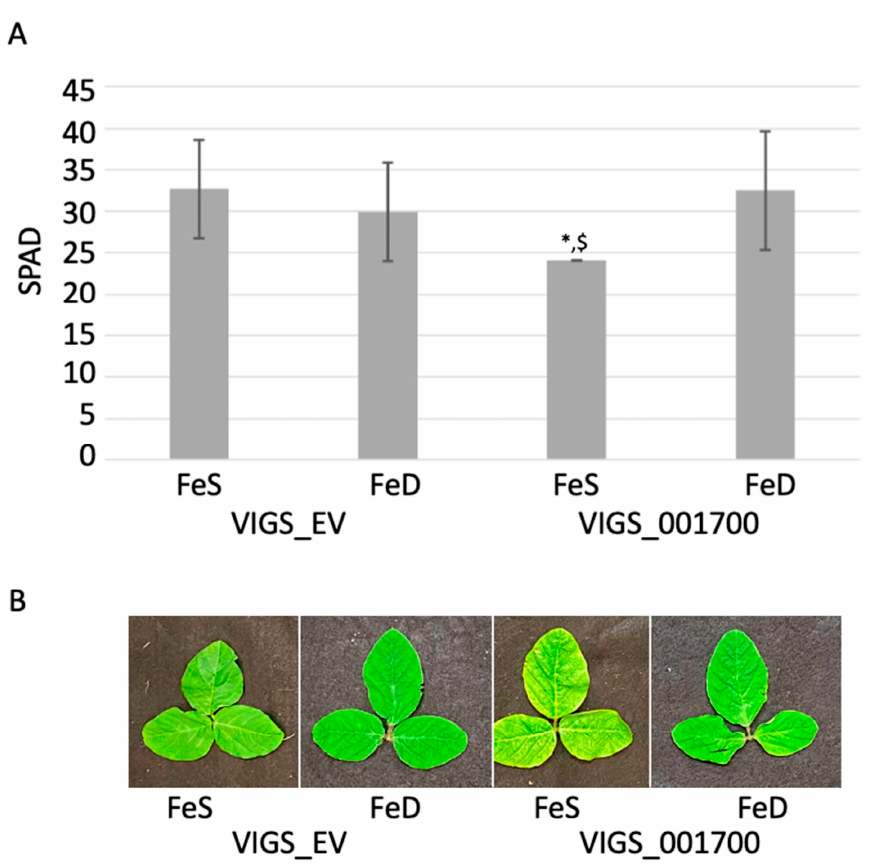
Figure 2. Phenotypic analysis of Fiskeby III infected with either empty vector or Glyma.05G001700 VIGS constructs in FeS and FeD hydroponic conditions. ( A ). SPAD readings at 14 days in hydroponics. Error bars are standard deviations calculated from six biological replicates. * indicates statistically significant differences between VIGS_Glyma.05G001700 in FeS and FeD conditions; $ indicates statistically significant differences between VIGS_Glyma.05G001700 in FeS and VIGS_EV in FeS. ( B ). Photographs of representative V4